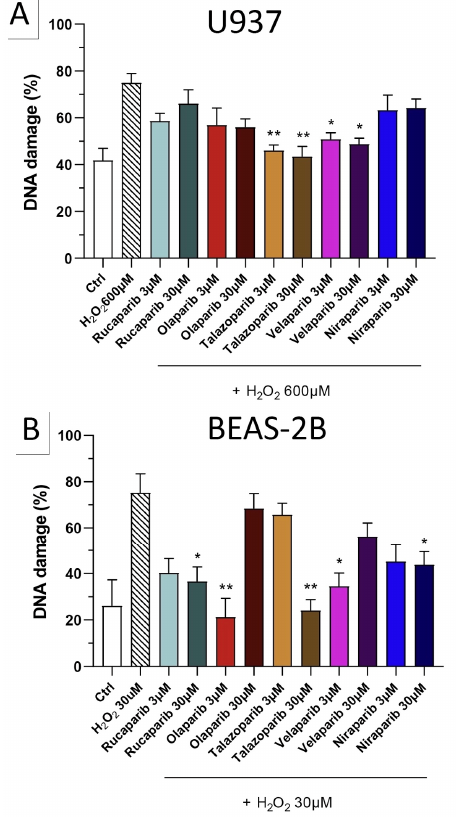
Figure 10. Effect of various clinical-stage PARP inhibitors on H 2 O 2 -induced DNA damage in ( A ) U937 and ( B ) BEAS-2B cells. U937 or BEAS-2B cells were treated for 2 h with 600 µM or 30 µM H 2 O 2 , respectively; the PARP inhibitors were added at different concentrations (3 and 30 µM). After 24 h, DNA damage was measured by the TUNEL assay. * p < 0.05 and ** p < 0.01 indicate the beneficial effect of the PARP inhibitors tested to reduce the degree of DNA damage in H 2 O 2 -treated cells. Data are shown as mean ± SEM of n = 5 independent experiments.